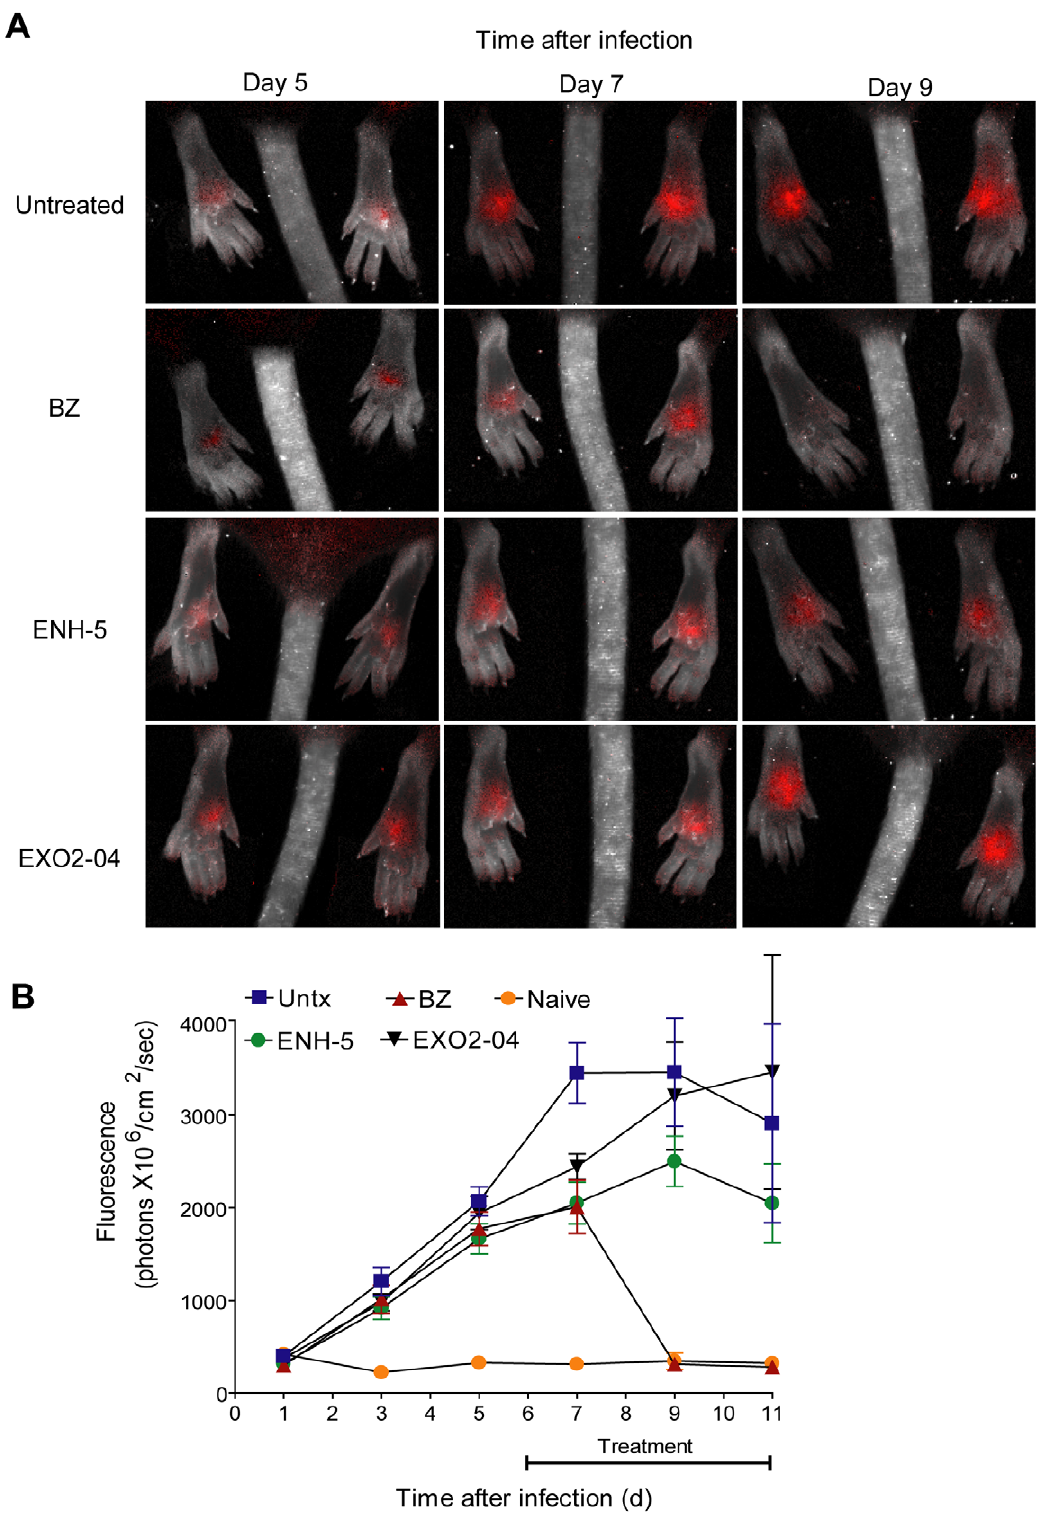
Figure 5. Fluorescent T.cruzi -tdTomato expressing parasites imaged post-treatment. Mice (10 per group) were infected in the hind foot pads with 2.5 6 10 5 T. cruzi tdTomato trypomastigotes and the images were taken every two days from day 1 to 11 post infection. (A) Images from days 5, 7 and 9 post infection. (B) Quantification of the fluorescent signal from mice in panel A at all imaging points.